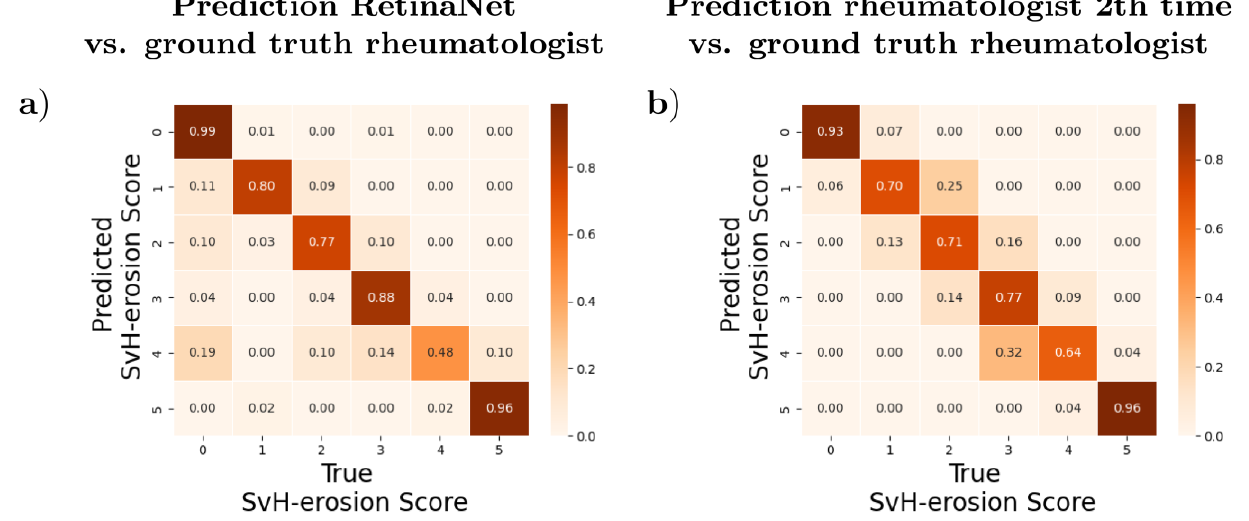
Figure 5. Comparison of confusion matrices: the X axis shows the assumed ground truth, i.e., the SvH erosion score of the experienced rheumatologist at time point 1, and the Y axis represents the erosion scores predicted by RetinaNet ( a ) and the erosion scores at the second time point determined by the same experienced rheumatologist, respectively ( b ). We found that both the AI and the rheumatologist confidently classified the extreme points SvH erosions with a score of 0 and 5, respectively, and showed no discrepancies. However, RetinaNet tended to classify a joint as 0 more often than average, whereas the rheumatologist deviated exclusively by one from the previous